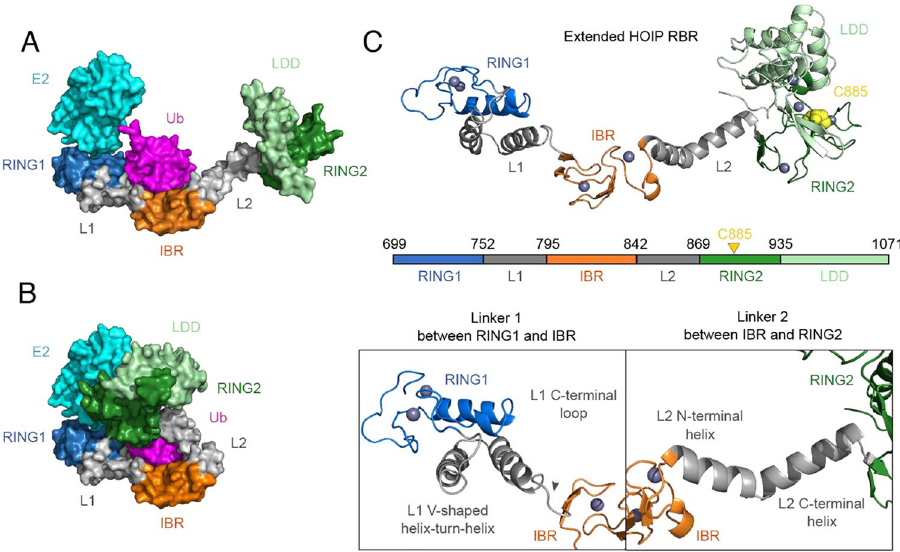
Figure 2. Structural models of the HOIP RBR domain. ( A ) The extended and and ( B ) compact conformation of HOIP RBR domain observed in the crystal structure (5EDV), respectively. UbcH5B is coloured in cyan and conjugated ubiquitin is coloured in magenta. ( C ) The model of the extended HOIP RBR domain consists of RING1 (699–751), L1 (752–795), IBR (796–841), L2 (842–868), RING2 (869–935) and LDD (936–1071) structural regions. In this study, the RING2-LDD supradomain is referred to as the RING2 domain. L1 adopts a V-shaped helix-turn-helix motif that makes extensive contacts with RING1, whilst the short L1 C-terminal loop connects the helix-turn-helix to the IBR domain. L2 forms two helices, N-terminal and C-terminal, with a bend in the middle. RING1, IBR, RING2 and linkers are coloured blue, orange, green and grey, respectively. The catalytic cysteine C885 is shown as yellow spheres. Zn +2 ions are shown as dark blue